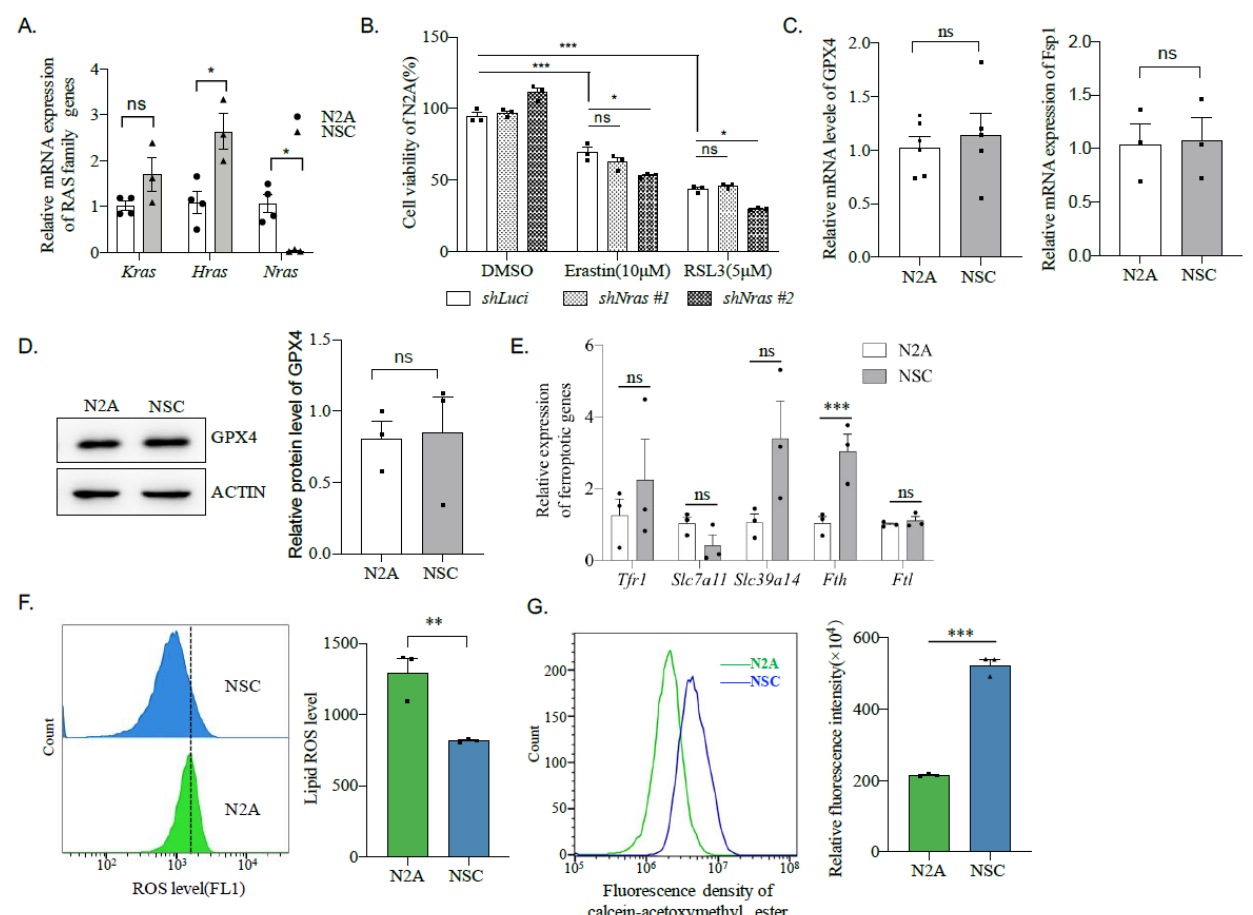
Figure 6. Low expression of Fth sensitizes N2A cells to ferroptosis inducers. ( A ) The expression of RAS family genes in N2A and neural stem cells was analyzed by qPCR. Data were obtained from the indicated number of samples. *: p < 0.05; ns: not significant. ( B ) Cell viability of N2A with Nras silencing and Erastin and RSL3 treatment. *: p < 0.05; ***: p < 0.001; ns = no significance. ( C ) The mRNA expression of Fsp1 and GPx4 between N2A and NSC. ns: not significant. ( D ) The protein expression of GPx4 between N2A and NSC. ns = no significance. ( E ) The mRNA expression of Tfr1, Slc7a11, Slc39a14, Fth, and Ftl between N2A and NSC. ***: p < 0.001; ns: not significant. ( F ) Lipid ROS level in N2A cell and NSC detected by FACS. **: p < 0.01. ( G ). Labile iron pool in N2A and NSC was detected by incubation cells with 0.6 µ M of calcein-acetoxymethyl ester fluorescence probe for 1h before analyzing with FACS. ***: p <